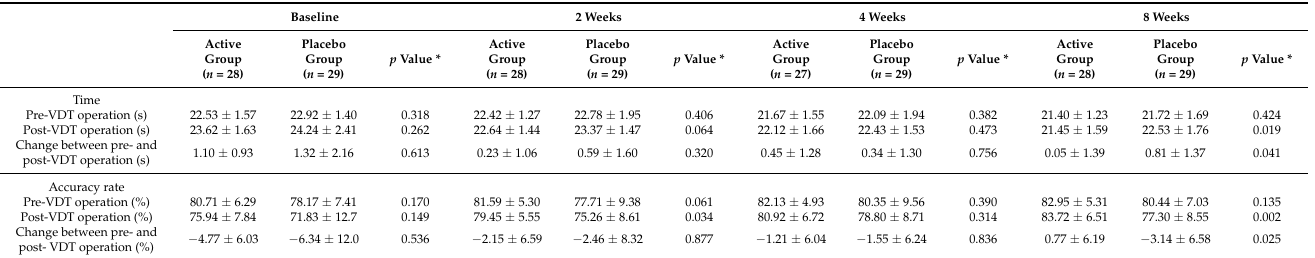
Table 3. The results of the eye–hand coordination